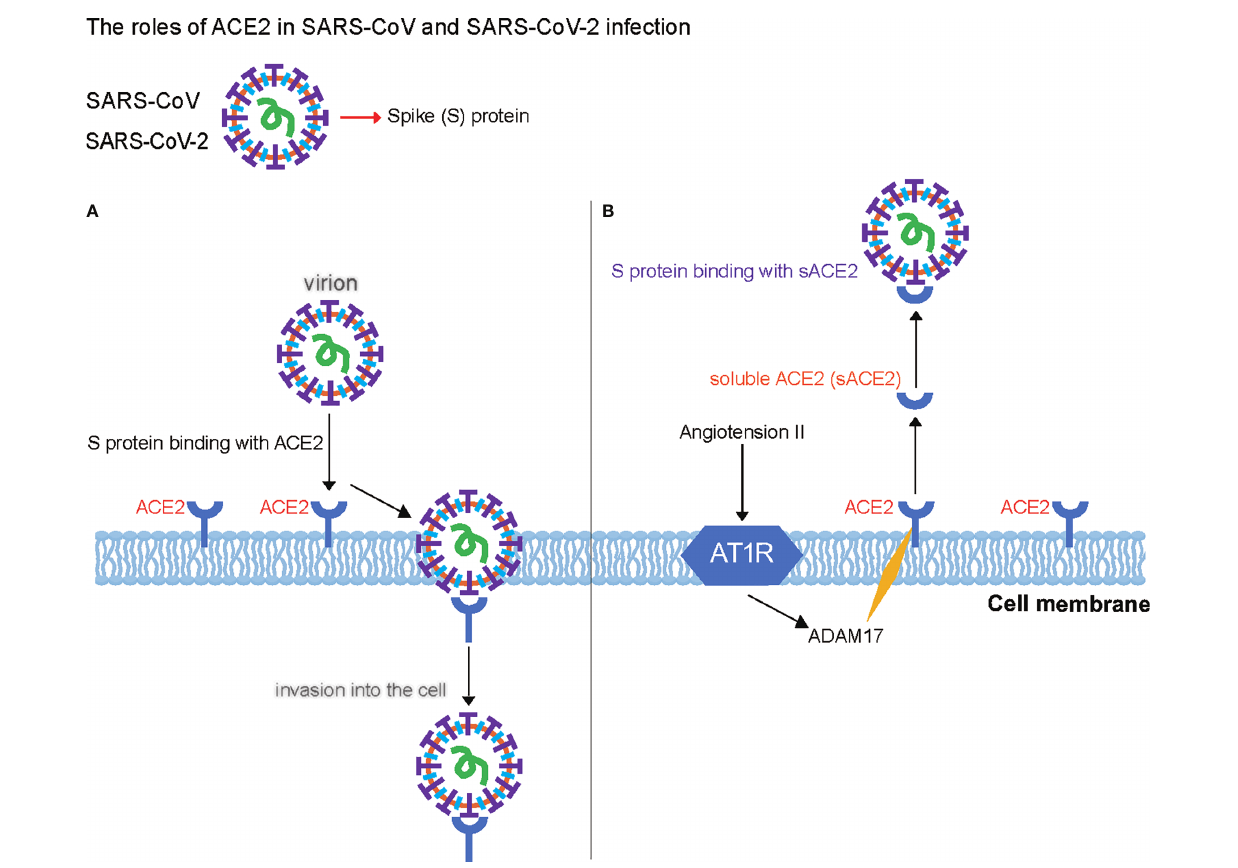
FIGURE 2 | Roles of angiotensin-converting enzyme 2 (ACE2) in severe acute respiratory syndrome coronavirus (SARS-CoV) and SARS-CoV-2 infection. (A) ACE2 acts as the key receptor in avian in fl uenza H5N1 and H7N9 virus infections as well as in SARS-CoV and SARS-CoV-2 infections. (B) Roles of a soluble form of angiotensin-converting enzyme 2 (sACE2) and A disintegrin and metalloprotease 17 (ADAM17) in cells infected with SARS-CoV and SARS-CoV-2. ADAM17 cleaves ACE2 and forms a 20-amino acid transmembrane peptide. The binding of Ang II with AT1R promotes sACE2 formation by increasing ADAM17 activity, which generates sACE2 and binds to the spike protein of SARS-CoV-2 as the virus